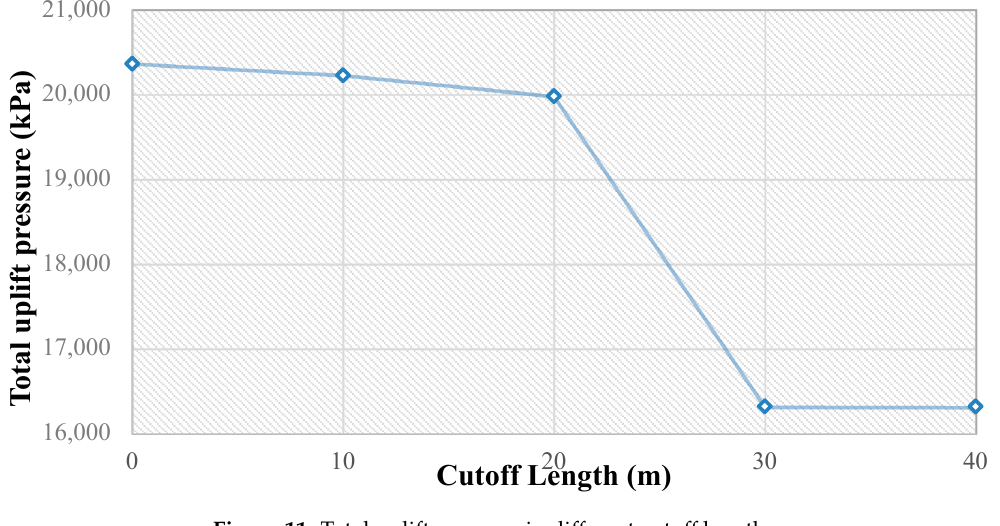
Figure 11. Total uplift pressure in different cutoff lengths.